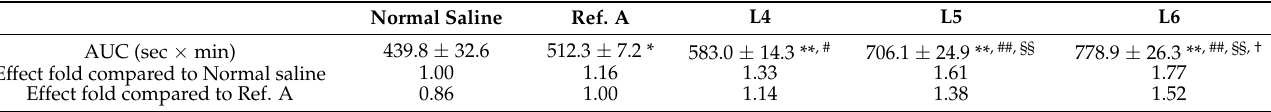
Table 3. Area under the curve (AUC) of latency profile and effect ratio for the tail-flick